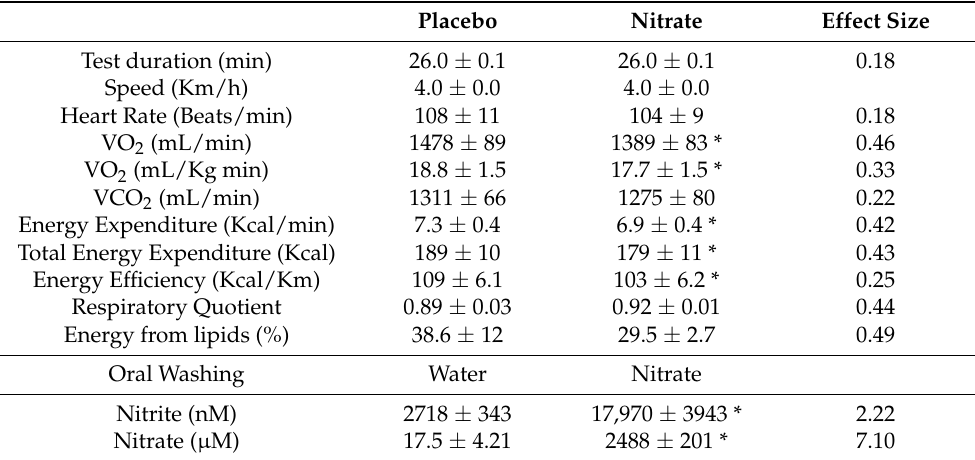
Table 2. Parameters of an exercise test at 60–70% of maximal heart rate after the intake of a placebo or a nitrate-rich beverage.